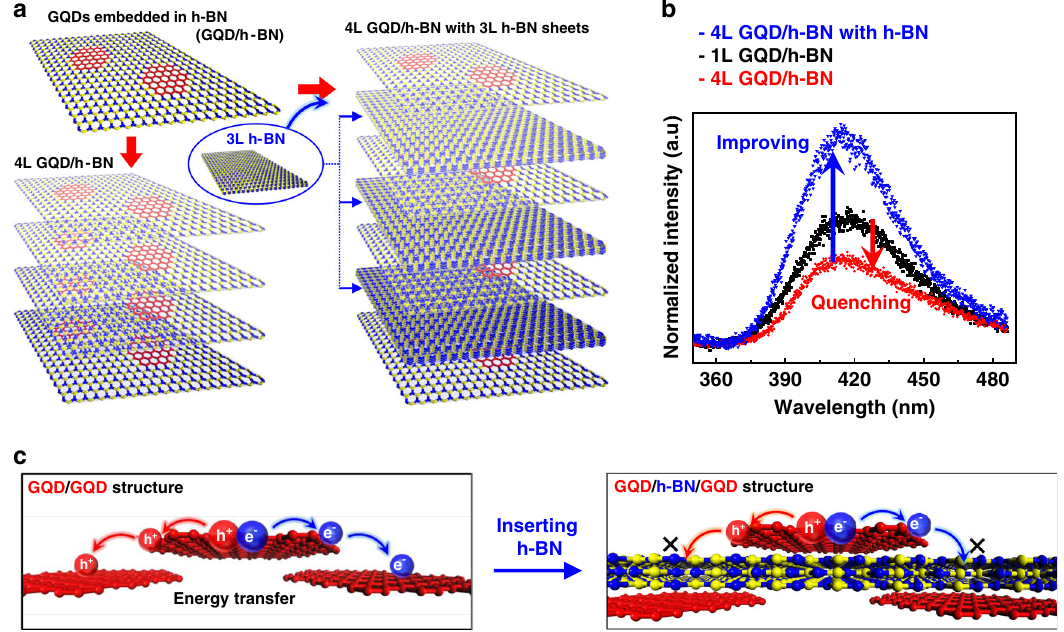
Fig. 4 Vertically stacked GQD/h-BN layers with h-BN barriers. a Schematic of the preparation process for two kinds of stacked GQD/h-BN fi lms. b PL spectra of stacked GQD/h-BN on a SiO 2 /Si substrate: a four layer stack of GQD/h-BN fi lms (4L GQD/h-BN, red spectrum), 4L GQD/h-BN with an additional h-BN intercalation layer between each GQD/h-BN fi lm (4L GQD/h-BN with h-BN, blue spectrum), and a single layer of GQD/h-BN fi lm (black spectrum, same as the red spectrum in Fig. 2d). c Schematic of the nonradiative charge transfer between GQDs in adjacent